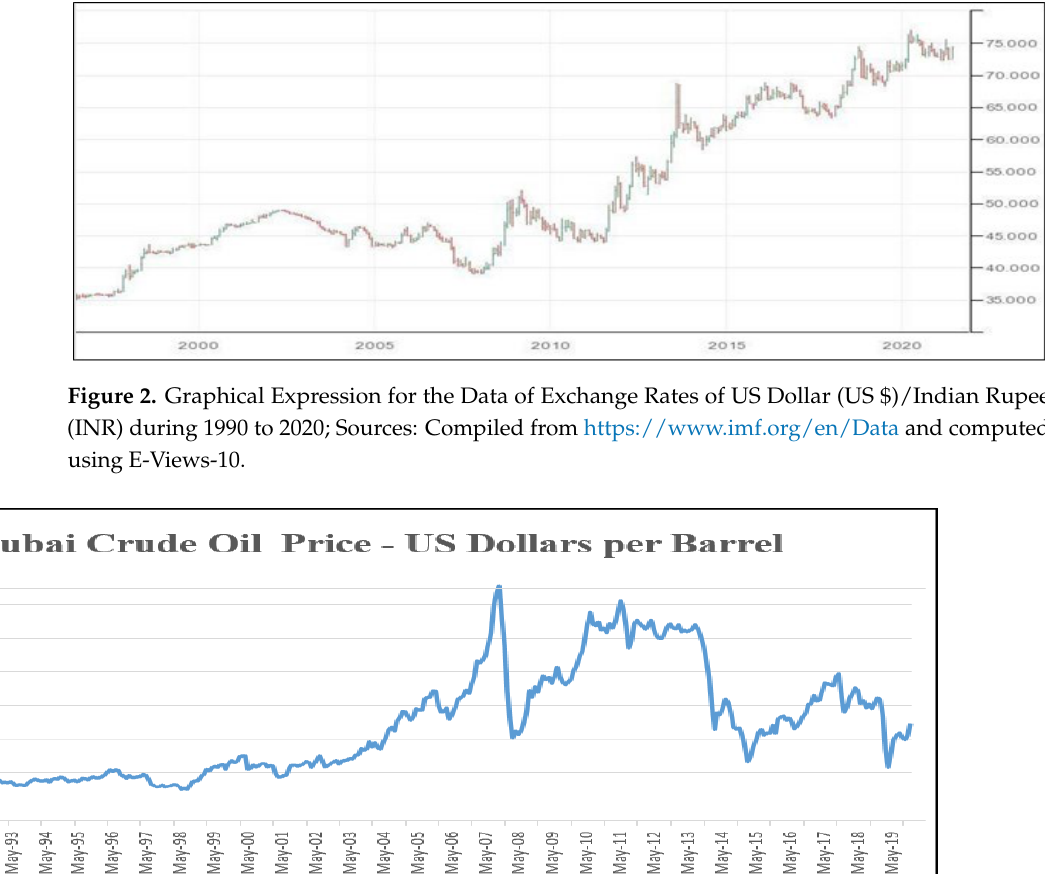
Figure 1. Graphical Expression for the Data of GDP per Capita in India during 1990 to 2020; Sources: Compiled from https://databank.worldbank.org/home.aspx and computed using E.Views-10.